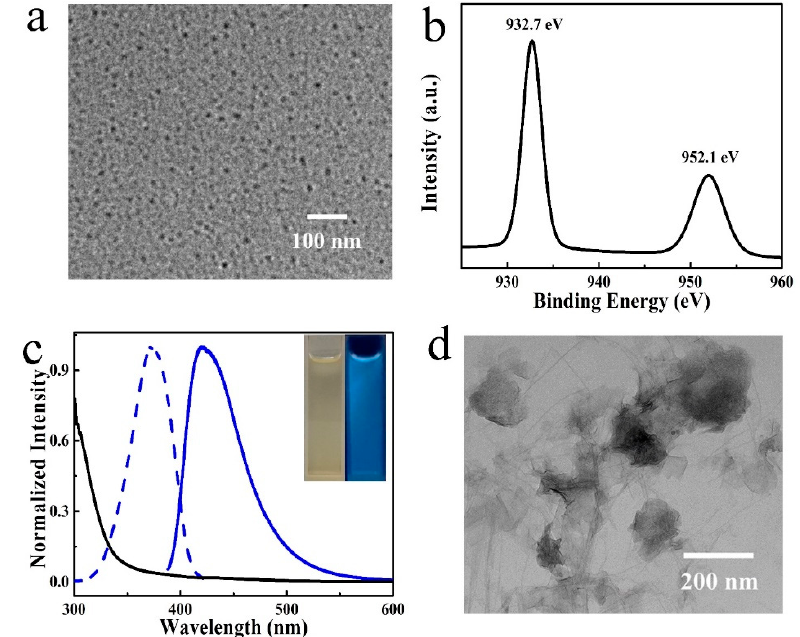
Figure 2. Characterization of Cu NCs and MnO 2 nanosheets. ( a ) TEM, ( b ) high-resolution Cu 2p XPS spectrum, ( c ) fluorescence emission (blue solid line), excitation (blue dotted line), and UV-visible absorption spectra of Cu NCs. ( d ) High-resolution Mn 2p XPS spectrum of MnO 2 nanosheets.